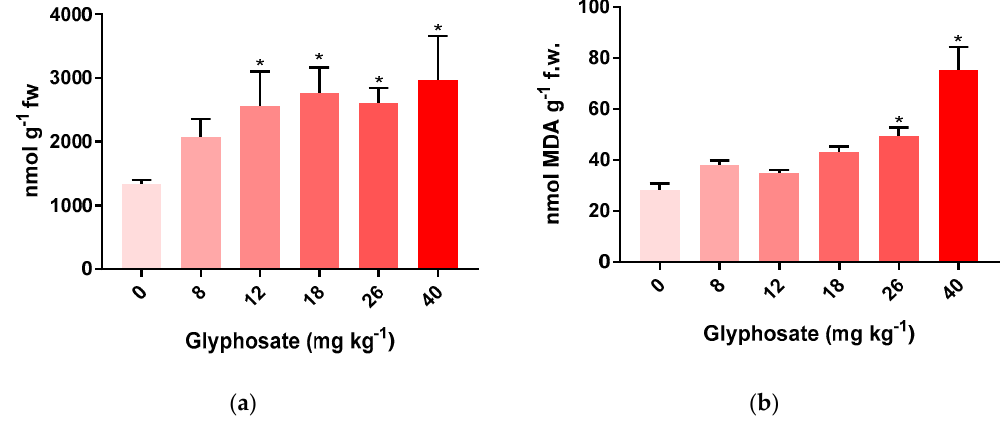
Figure 4. Average concentrations of H 2 O 2 ( a ) and malondialdehyde (MDA) ( b ) in shoots of M. sativa plants 21 days after exposure to increased concentrations of GLY. Error bars correspond to the standard deviation. Statistically significant di ff erences compared to the CTL, considering p ≤ 0.05, are marked with a * above